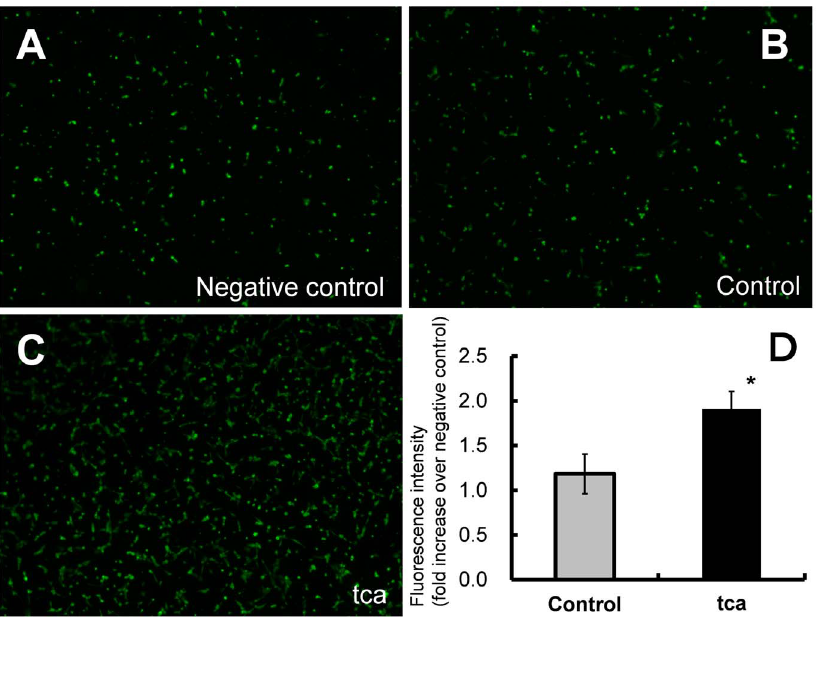
Figure 3. HUVEC migration using ESCC-DR culture supernatants. Culture supernatants were collected from control cells incubated in the medium without TCA and tca cells incubated in the medium with 2 mM TCA for 24 h. (A–C) Fluorescence microscopy was used to detect calcein- labeled HUVEC cells migrating through fibronectin-coated membranes toward a negative control solution (HBSS) (A), control cell culture supernatant (B) and tca cell culture supernatant (C). ( 6 40) (D) Comparison of HUVEC migration between culture supernatant of tca vs. control cells (* P , 0.05). The fluorescence intensities of control and tca supernatants were normalized to that of the negative control.